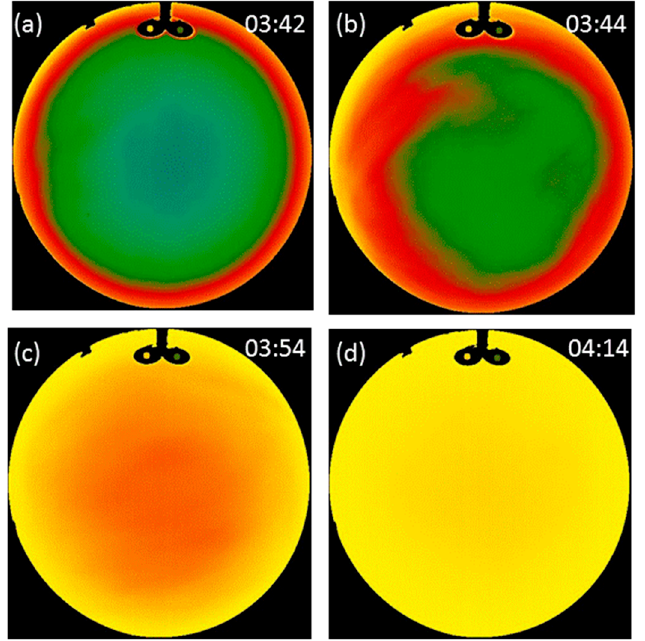
Figure 7. Sky image on 6 January 2021. ( a ) 03:42—the fog is low and the sky image is clear. ( b ) 03:44—the fog is rising rapidly. The slight asymmetry shows that the fog developed from the northeast direction. ( c ) 03:54—the fog covers the entire sensor’s field of view, but not very densely. There is still a temperature gradient that follows the elevation angle. ( d ) 04:14—Fully developed dense fog. The sky brightness temperature is homogenous and its magnitude is the same as the air temperature.